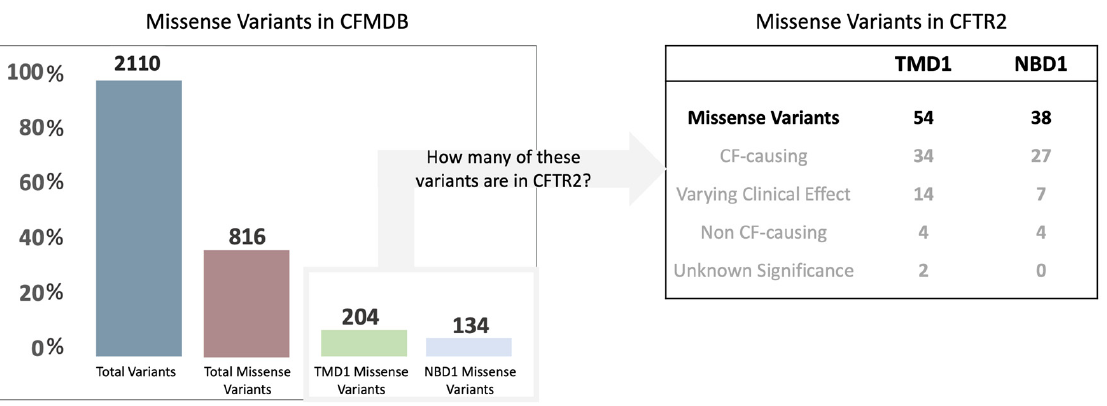
Figure 1. ( left ) Graphical representation of the total number of variants in CFMDB and the number of missense variants localized in TMD1 and NBD1. ( right ) Table indicating the number and classification of missense variants in CFTR2 (for a more detailed table, see Supplementary Table S1).